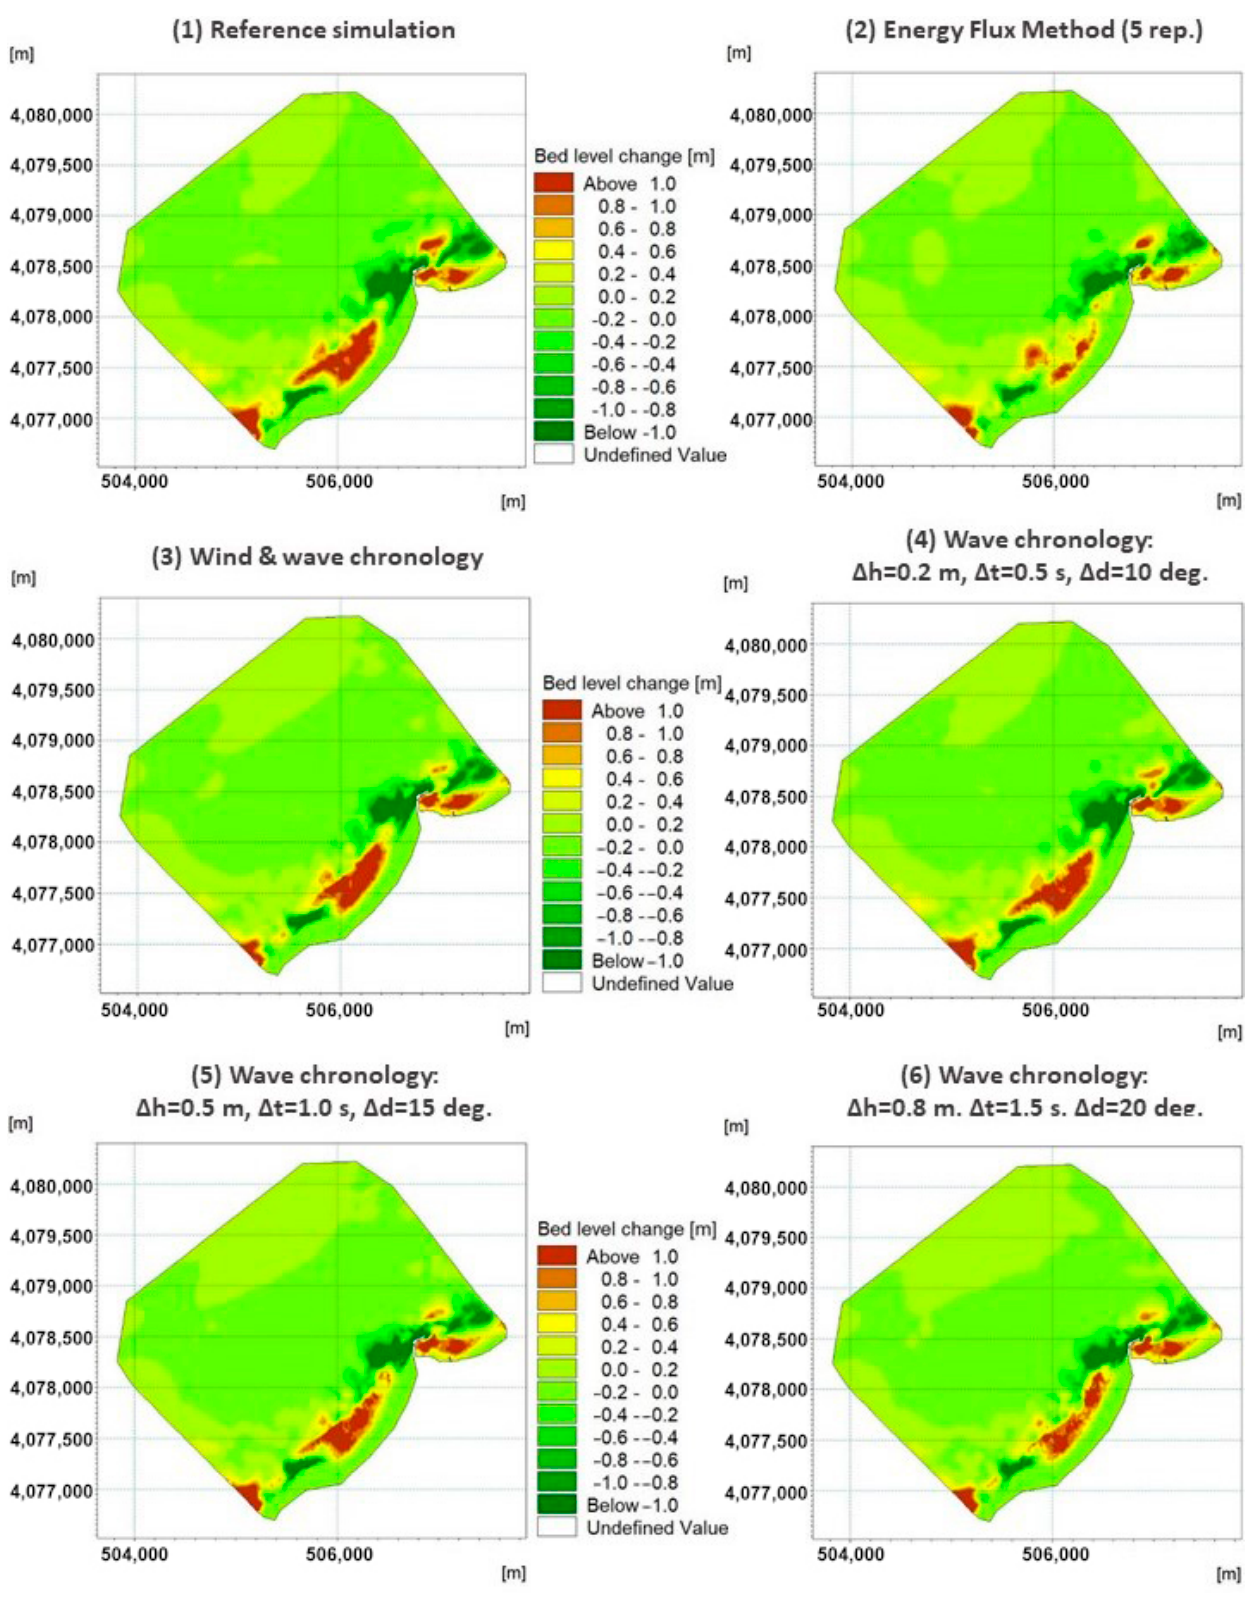
Figure 9. Visual comparison of the reference simulation and the applied wave input reduction techniques simulations regarding the final bottom evolution at the end of 2021.